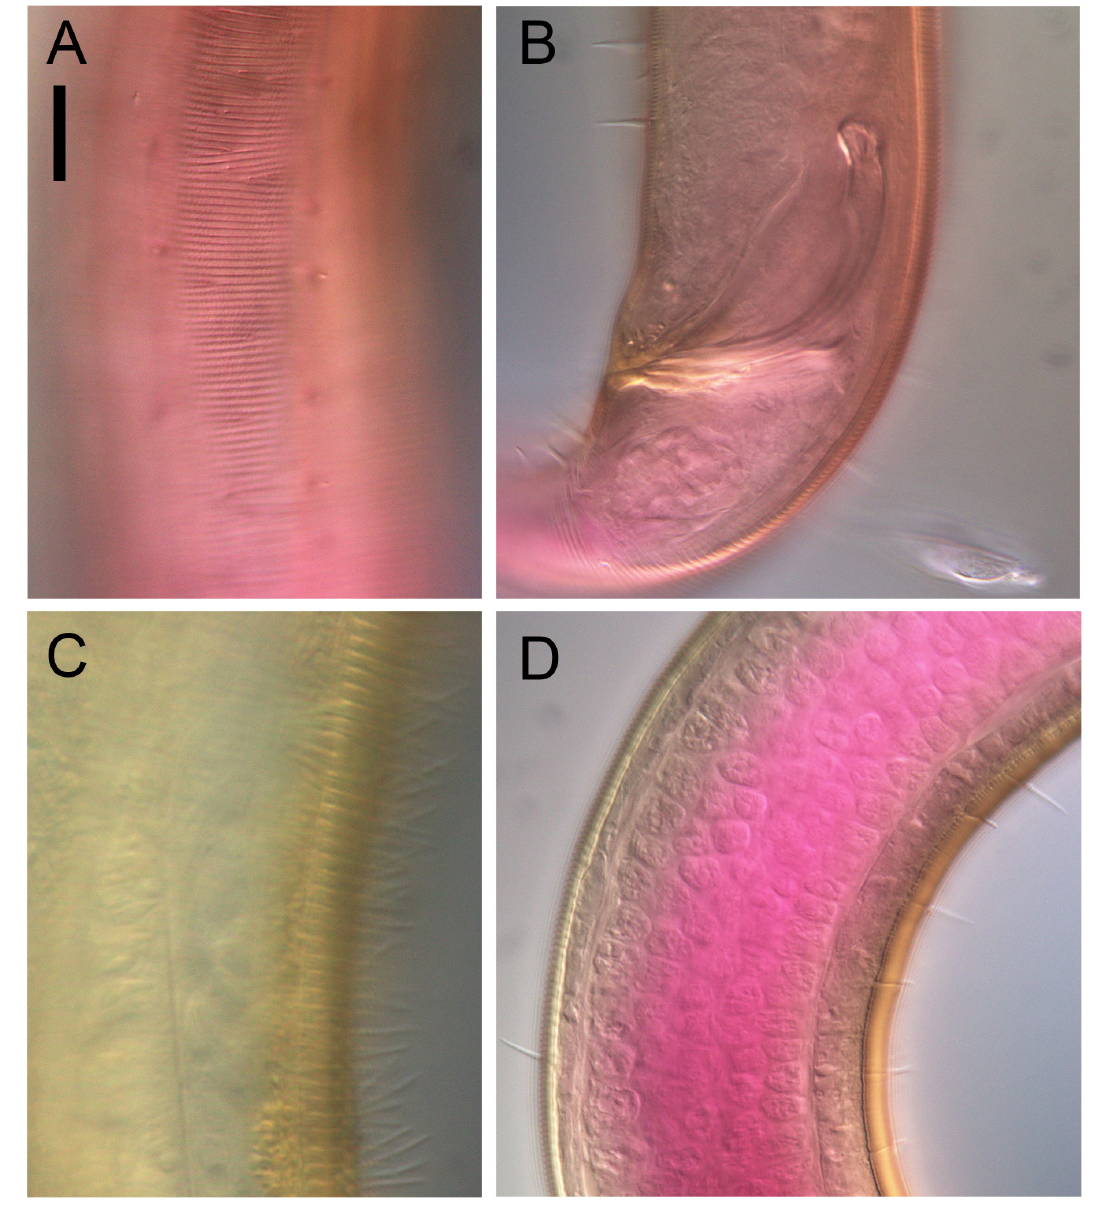
Fig. 18. Desmodora parapilosa sp. nov. Light micrographs of male, paratype (NIWA154922). A . Cuticle, mid-body region. B . Copulatory apparatus. C . Cuticle with attached bacteria. D . Sperm. Scale bar: A = 20 µm; B, D = 17 µm; C = 13